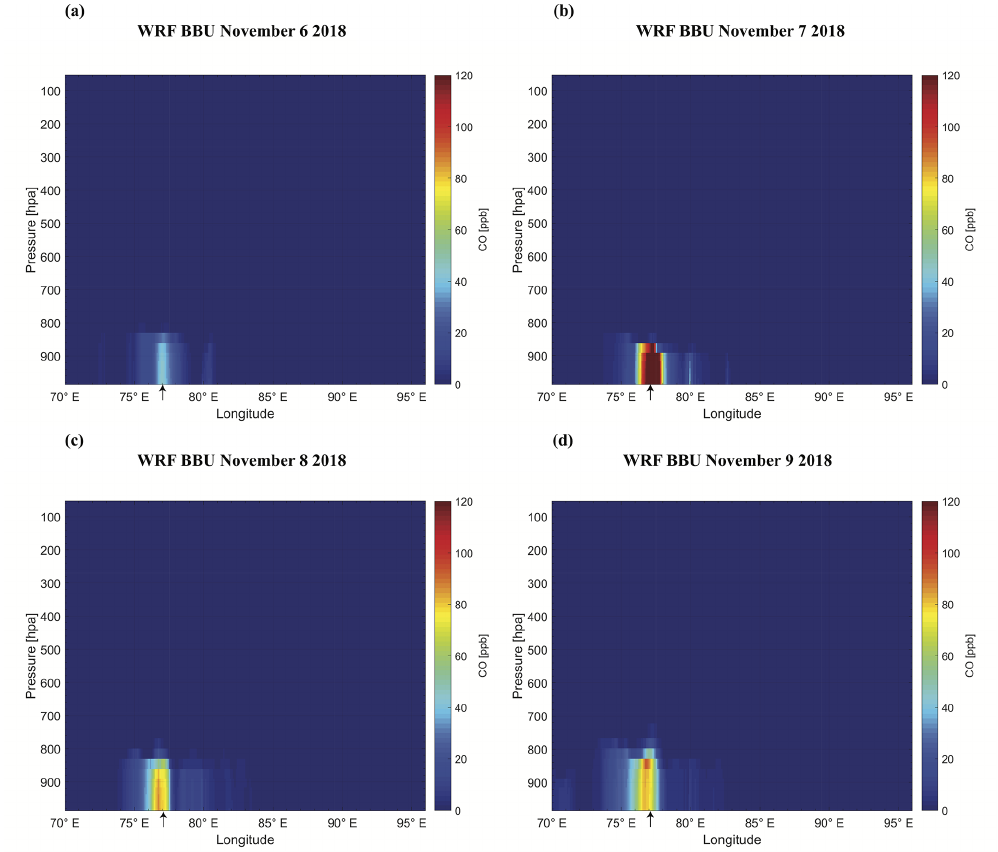
Figure 10. Vertical cross section of the CO mixing ratio that arises from biomass burning emissions during 6–9 November 2018. Cross sections are over Delhi at 13:30 (local time). The black arrow indicates the location of